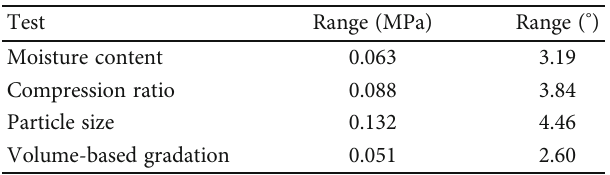
Figure 11: Sensitivity factor curves of the compressive stress. Table 6: Ranges of the in fl uence factors of cohesion and internal friction